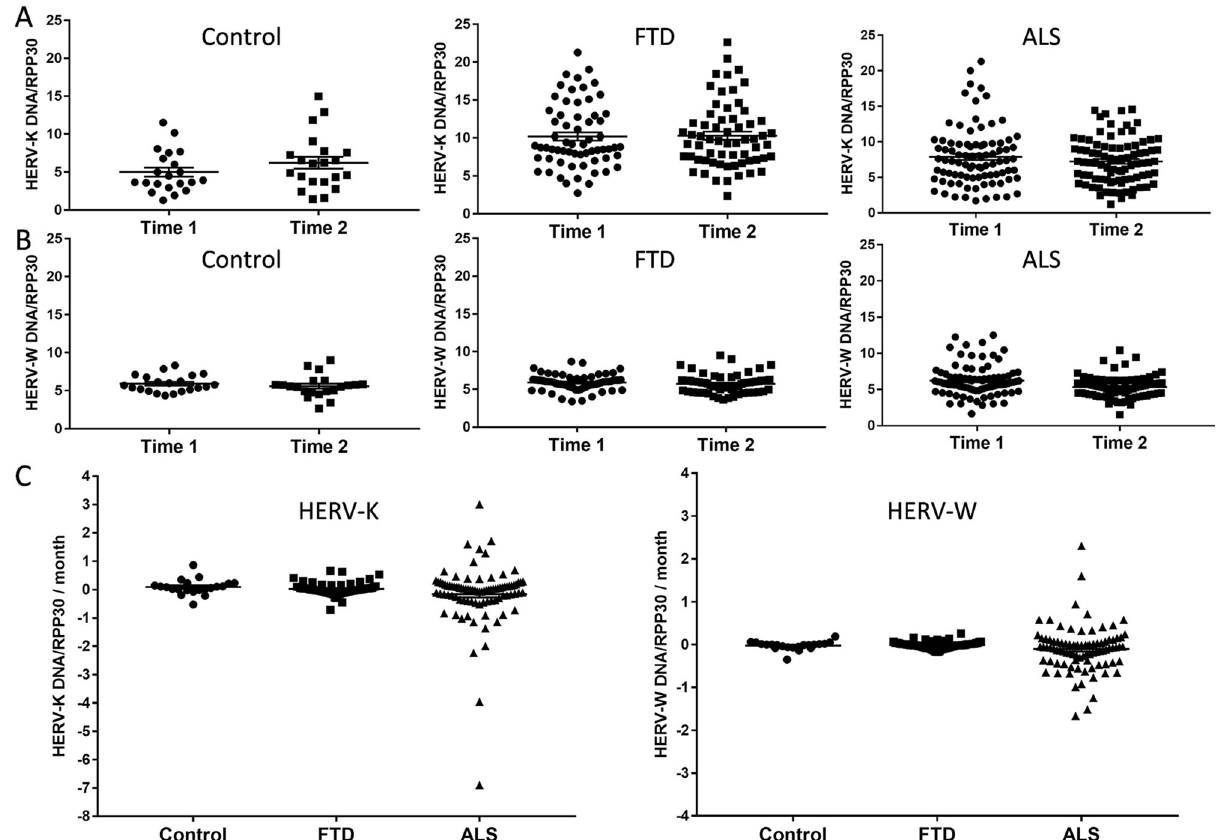
Fig. 6 A longitudinal assessment of HERV-K levels in FTD and ALS serum. A HERV-K levels at two time points; the mean of number of months between the two time points were 28 for FTD ( n = 63), 9 for ALS ( n = 89) and 22 for controls ( n = 21). B HERV-W levels at two time points in FTD ( n = 63), ALS ( n = 89) and control ( n = 21) serum. C Rate of change in HERV-K and HERV-W levels in FTD ( n = 63), ALS ( n = 89) and control ( n = 21) serum. Data represent individual patients, mean and SE as error